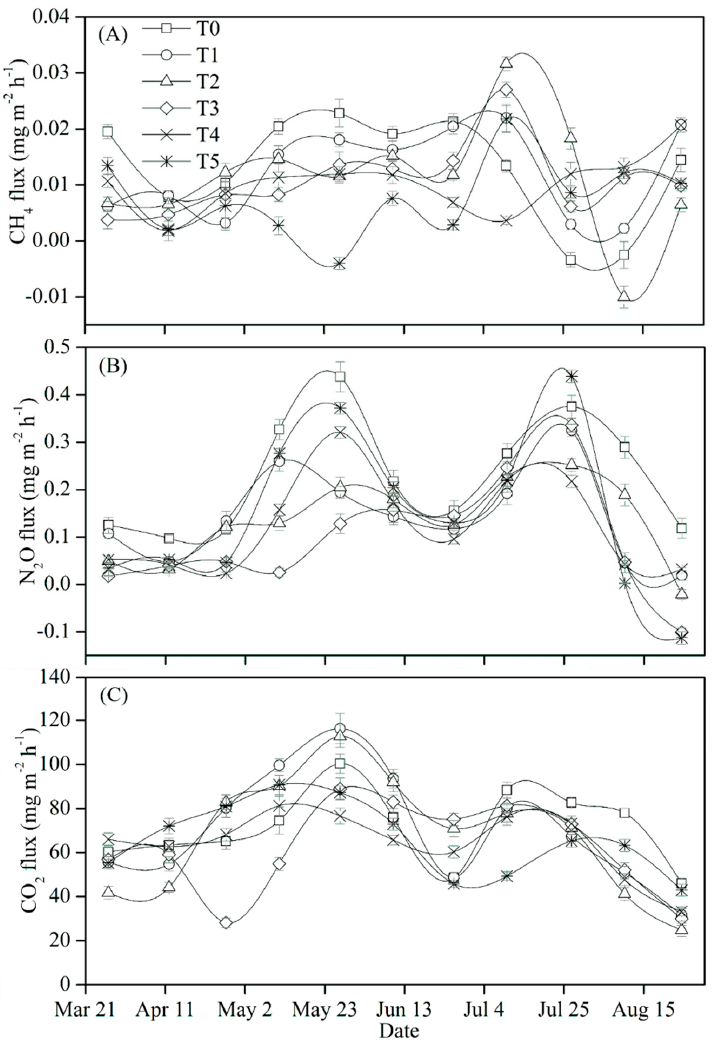
Figure 3. Seasonal variations of CH 4 ( A ), seasonal variations of N 2 O ( B ) and seasonal variations of CO 2 ( C ) fluxes respectively for spring wheat measured during the growing season of 2015. Bars indicate standard errors (SE) at p < 0.05. Treatments are biochar applied at 0, 10, 20, 30, 40, and 50 t ha − 1 (corresponding to T0, T1, T2, T3, T4, and T5), respectively.